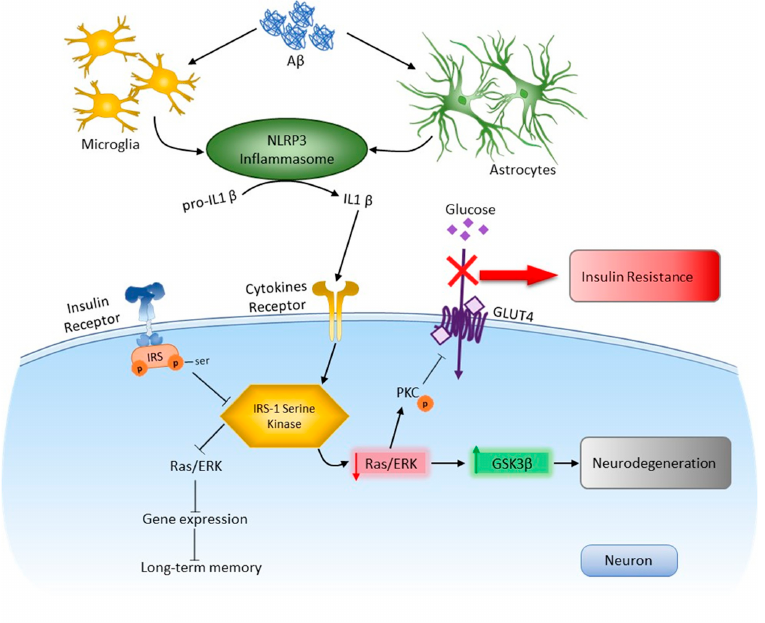
Figure 12. Role NLRP3 inflammasome in neurodegeneration and insulin resisance in response to DAMPs . In the brain, activation of toll-like receptors leads to the assembly of NLRP3 inflammasomes and the maturation and release of IL-1 β . Through cytokine receptors, kinases are changed. This leads to impaired insulin signaling and the development of insulin resistance, which leads to dysfunction of long-term memory and the development of neurodegeneration. A β —amyloid beta, Akt—protein kinase B, GSK3 β —glycogen synthase kinase 3 beta, IRS—insulin receptor substrate, NLRP3—NOD- like receptor pyrin domain-3 inflammasome, PKC—protein kinase C, Ras/ERK—kinase regulated by extracellular signals.